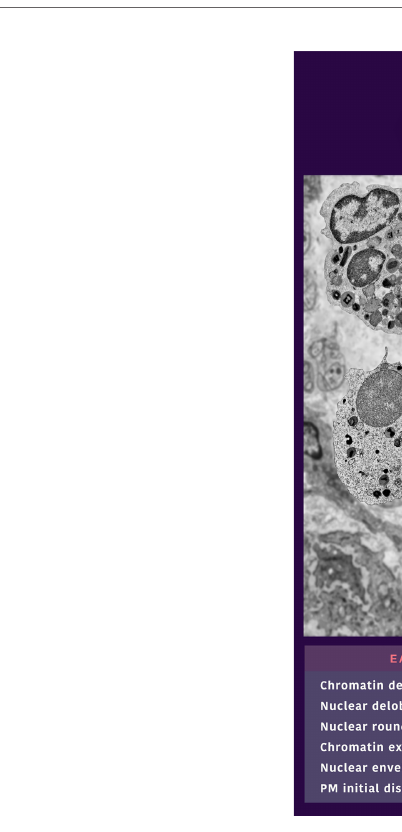
FIGURE 10 | In vivo ultrastructural features of eosinophil ETosis (EETosis) observed in tissues during in fl ammatory human eosinophil-associated diseases. EETosis is characterized by early and late signs, which compose an ultrastructural signature by TEM. Remarkable nuclear changes and initial breakdown of the plasma membrane (PM) indicate early signs of EETosis. The nuclear envelope can show structural changes (vesiculation and enlargement of the perinuclear space between the outer and inner nuclear membrane). Eosinophils at late ETosis show complete disruption of the PM, disruption of the nuclear envelope, and release of secretory granules and EoSVs together with spread chromatin observed as extracellular traps (ETs). Charcot-Leyden crystals (CLCs) are frequently associated with